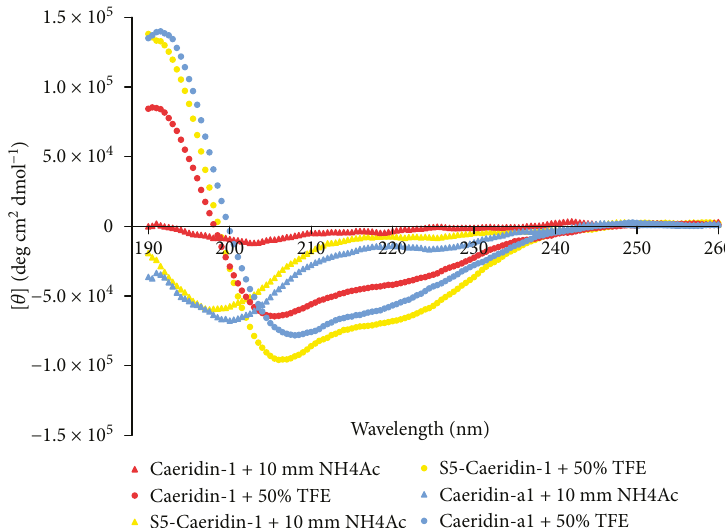
Figure 6: CD spectra under di ff erent conditions measured from 260 nm to 190 nm and plotted as mean residue ellipticity θ versus wavelength. Table 2: Secondary structures of Caeridin-1, S5-Caeridin-1, and Caeridin-a1 deduced from CD spectra by K2D3 programme. Peptide